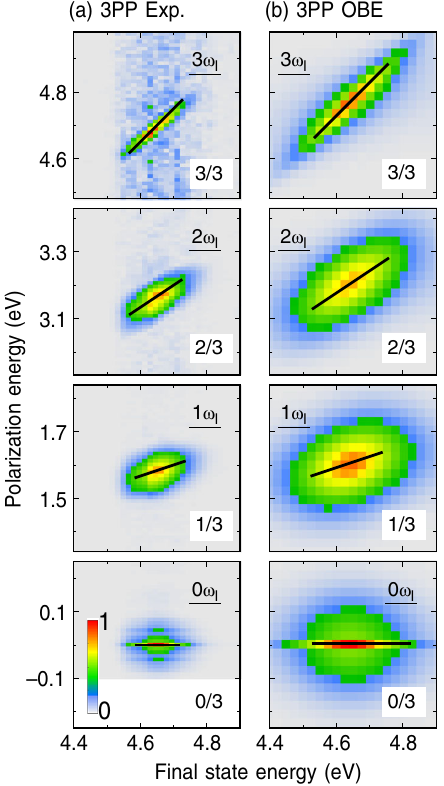
FIG. 8. 2D-FT photoelectron spectral components showing the SS signal generated by a Fourier analysis (a) of the ITR-3PP experiment based on Fig. 5(a) ( ℏ ω l ¼ 1 . 60 eV, k k ¼ 0 ) and (b) a four-level OBE simulation. The color range of each 2D spectrum is scaled independently. FT amplitudes disperse with final state and polarization energy. The tilt is highlighted by black lines, and their slopes are quantified in the white